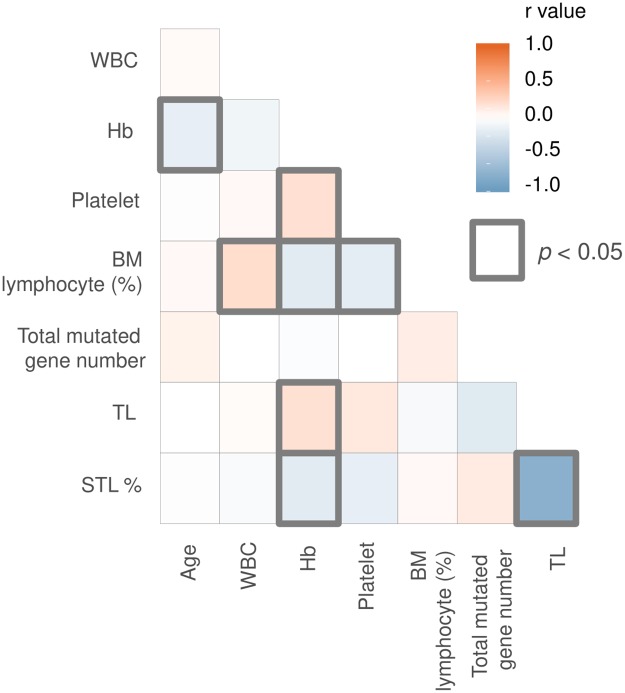
Correlation analysis of TL, the STL%, and clinical parameters.The graph shows that Hb had statistically significant correlations with TL (Tb = 0.188, p = 0.021) and the STL% (Tb = -0.207, p = 0.013). Significant correlations are marked as bold boxes. * Abbreviations: WBC, white blood cell; Hb, hemoglobin; BM, bone marrow.